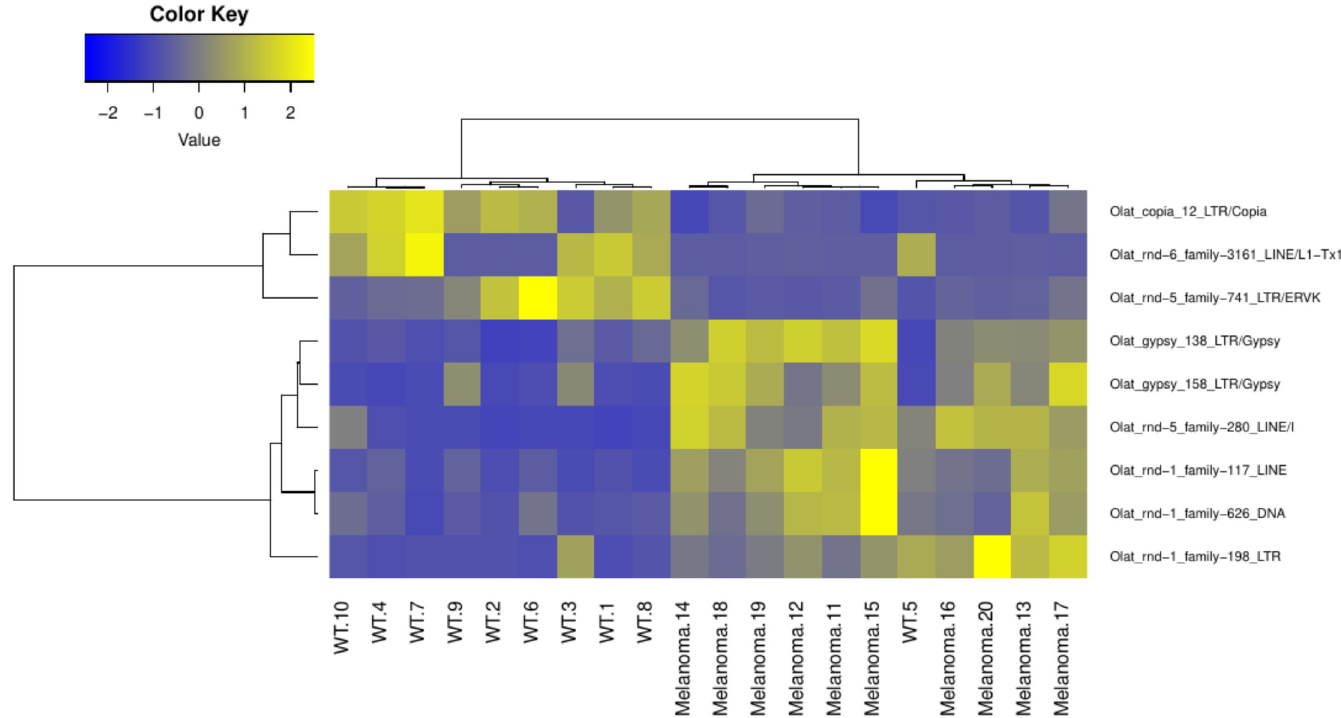
Fig 2. Heatmap of differentially expressed TE families. The analyses of differentially expressed TE families revealed distinct expression patterns of TEs. In wildtype (dataset 1–10) fish 3 TE families are overexpressed, whereas in melanoma bearing transgenic fish (dataset 11–20) 6 TE families are over-represented.